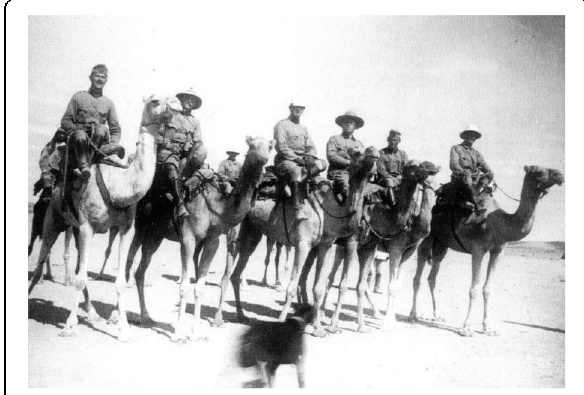
Fig. 3 Austro-Hungarian troops in Holy Land 1916 – 1918. Reconnaissance riding in the desert